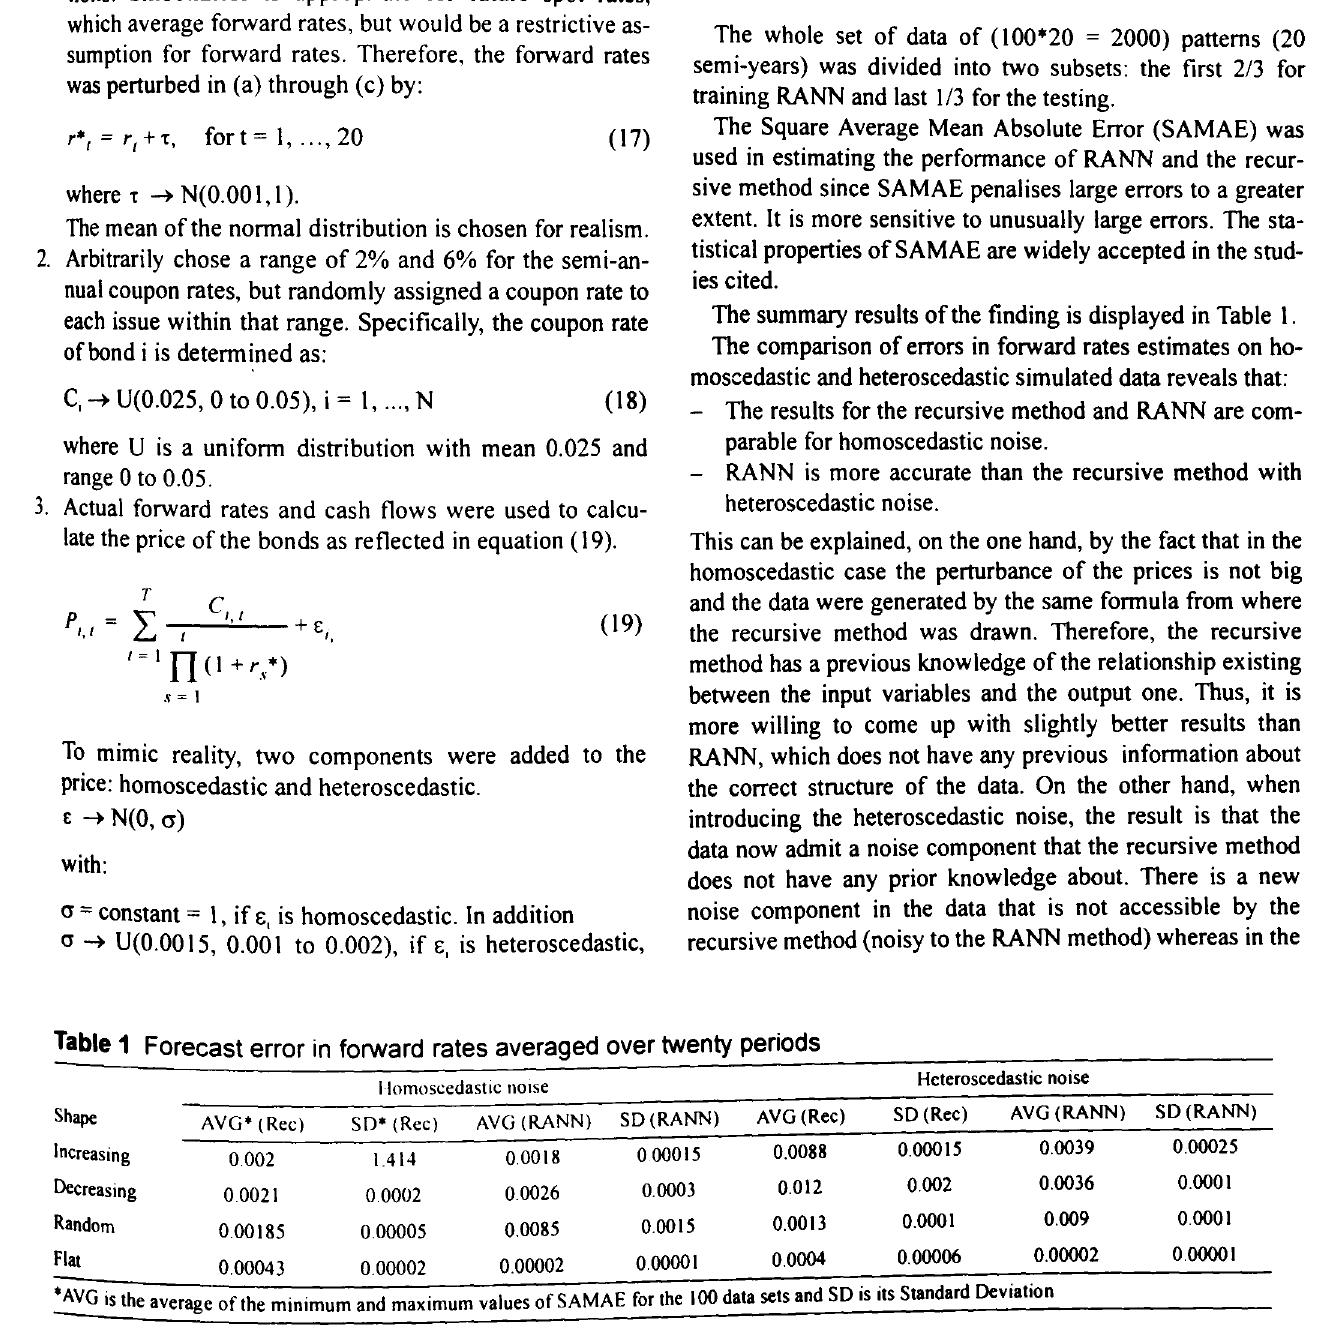
Table 1 Forecast error in forward rates averaged over twenty